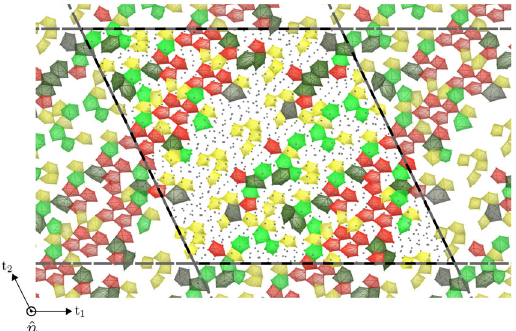
Fig. 13 The polyhedral unit model of the Σ 49 a ð 450 ; 221 ; 113 Þð 925 Þ general GB is illustrated. The units shown here are those obtained after the post-processing analysis described in section S3.4 of the Supplementary Information. The unit-cell of the GB is described ! ! ¼ ½ 5 ; 2 ; 16 (cid:5) and t ¼ ½ 16 ; 29 ; 7 (cid:5) . The boundary-normal by vectors t 1 2 vector along which the GB is viewed in this fi gure is